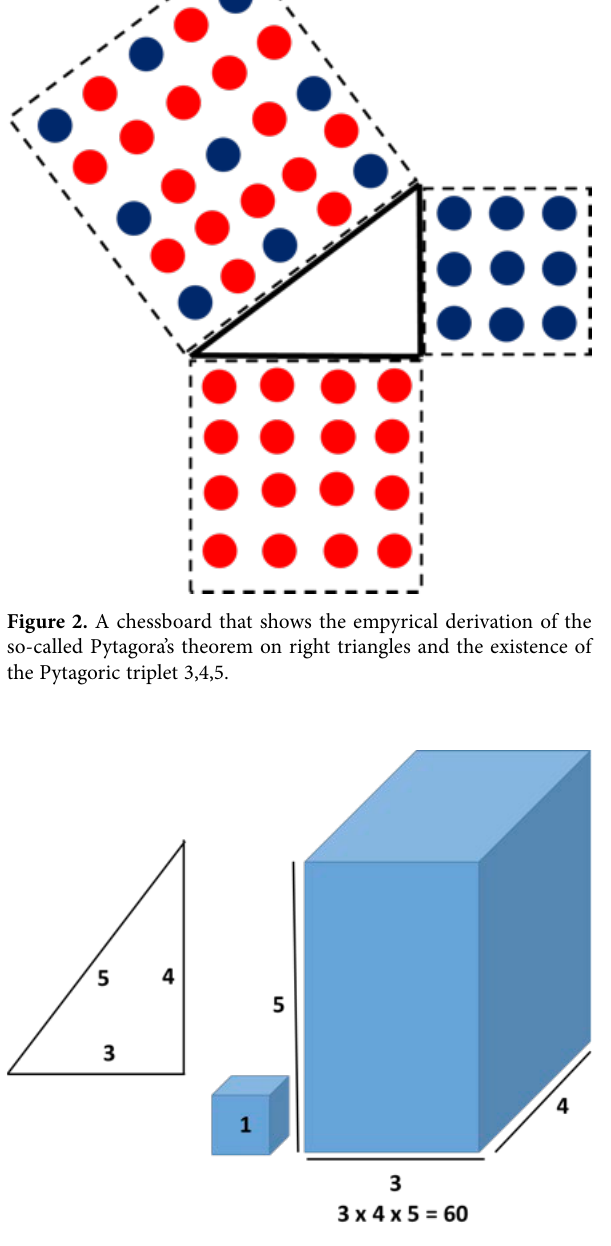
Figure 3. Relationship of two solids (containers), the larger exact- ly 60 times as much as the smaller, built as a unit-side cube (the smaller, acting as the unit-volume) and as a rectangular prism with sides in the 3:4:5 ratio of the fundamental Pythagorean triplet (the